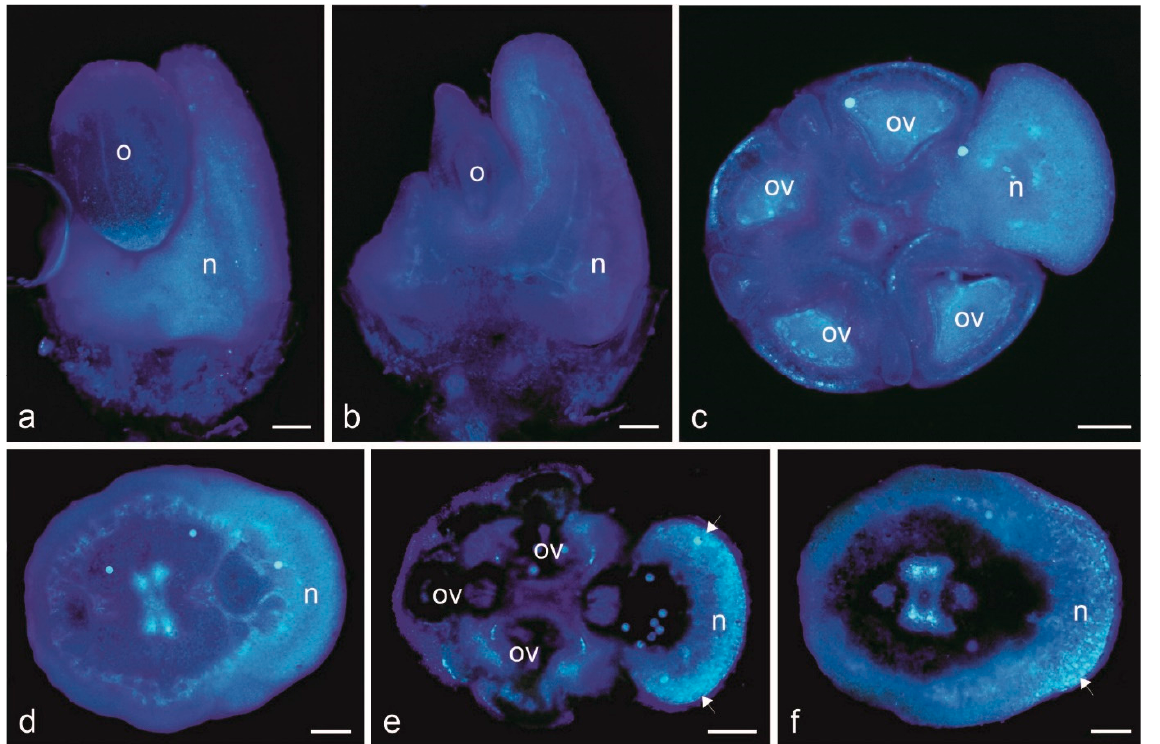
Figure 6. Results of fluorescence assays of Dracocephalum moldavica nectary cells. ( a , b )—a surface side view; ( c – f ) cross–sections. ( a – d ) Intense light blue autofluorescence of phenolic acids visible in the nectary cells; ( e , f ) Light yellow fluorescence of flavonoids in the presence of aluminium chloride fluochrome visible in the nectary epidermis and parenchyma (arrows); n—nectary; o—ovary; ov—ovules. Scale bars: 200 μ m ( a – f ).